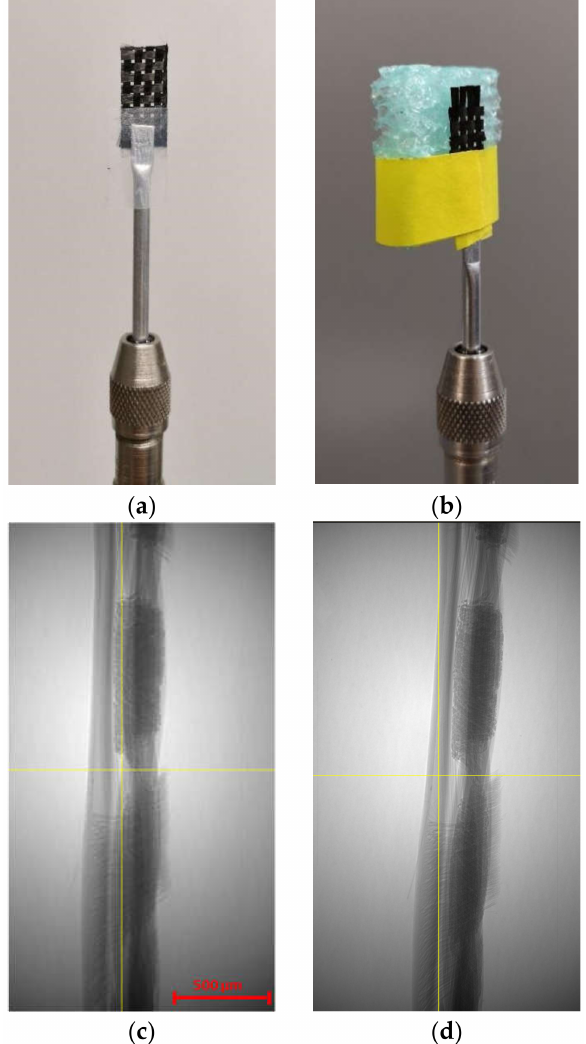
Figure 3. ( a ) The first trial of fixing the carbon dry fabric on the holder; ( b ) properly mounted sample to avoid wobbling during the scan; ( c ) position of the sample before scan after the first trial; ( d ) position of the sample after scan without the foam holder (after 5